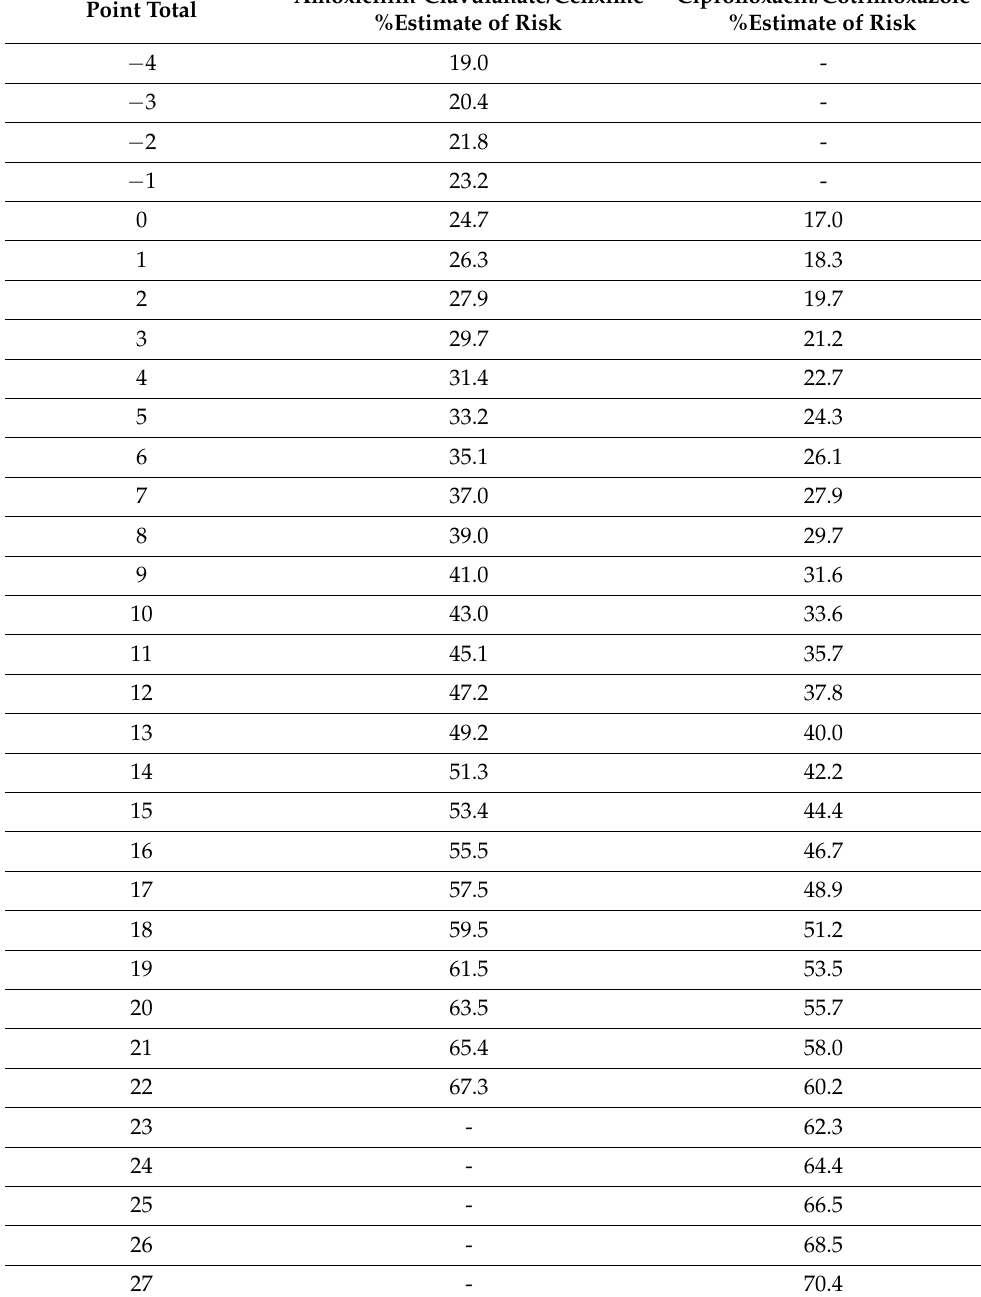
Table 4. Points system and risk estimates of isolating specific drug-resistant Enterobacteriales based on multivariable models reported in Table